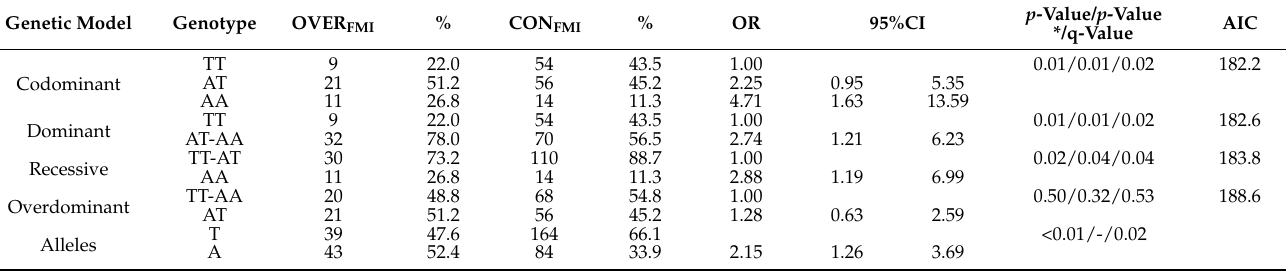
Table 6. Association analysis of the FTO (rs9939609) polymorphism with